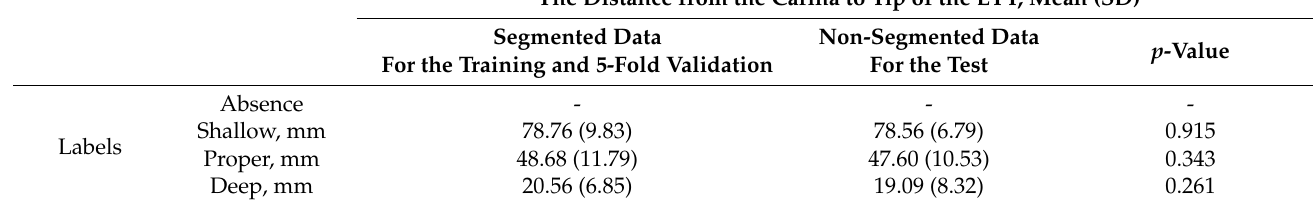
Table 1. Comparison of the distances from the carina of the trachea to the tip of the ETT between segmented and non-segmented datasets according to the labels.